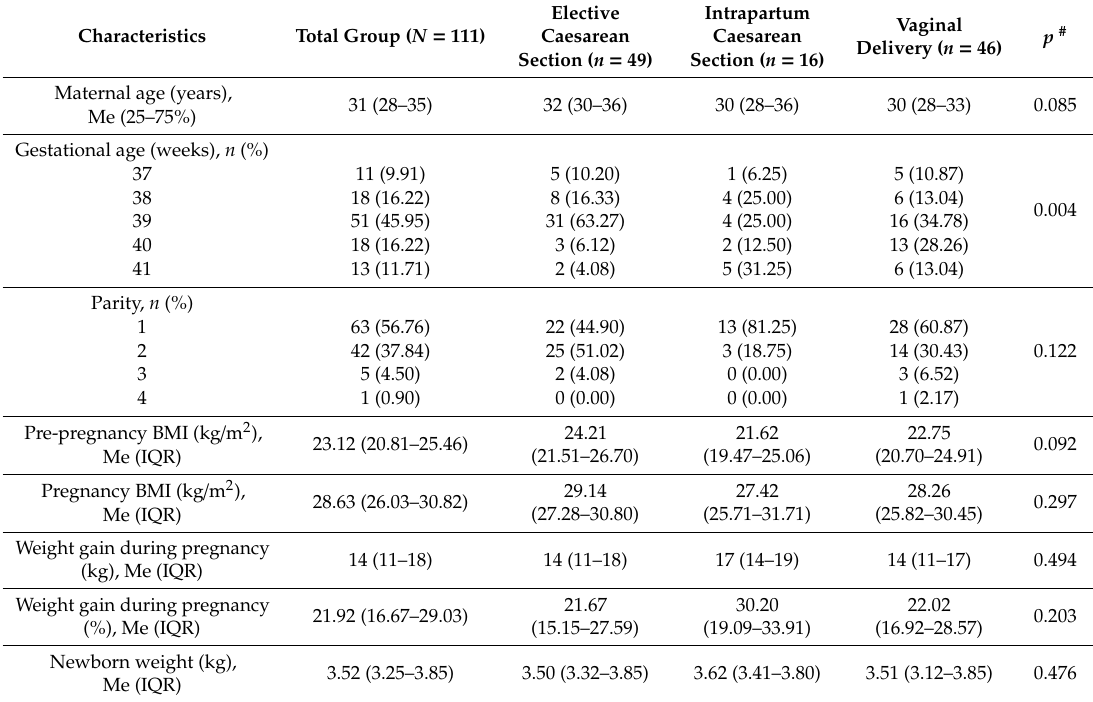
Table 1. Clinical characteristics of the study